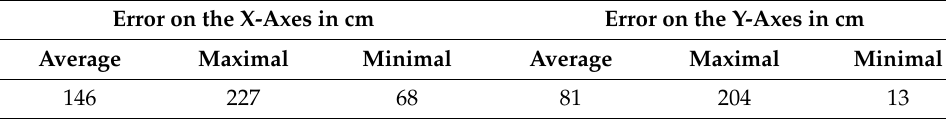
Table 1. Errors of token’s coordinates computing in static.